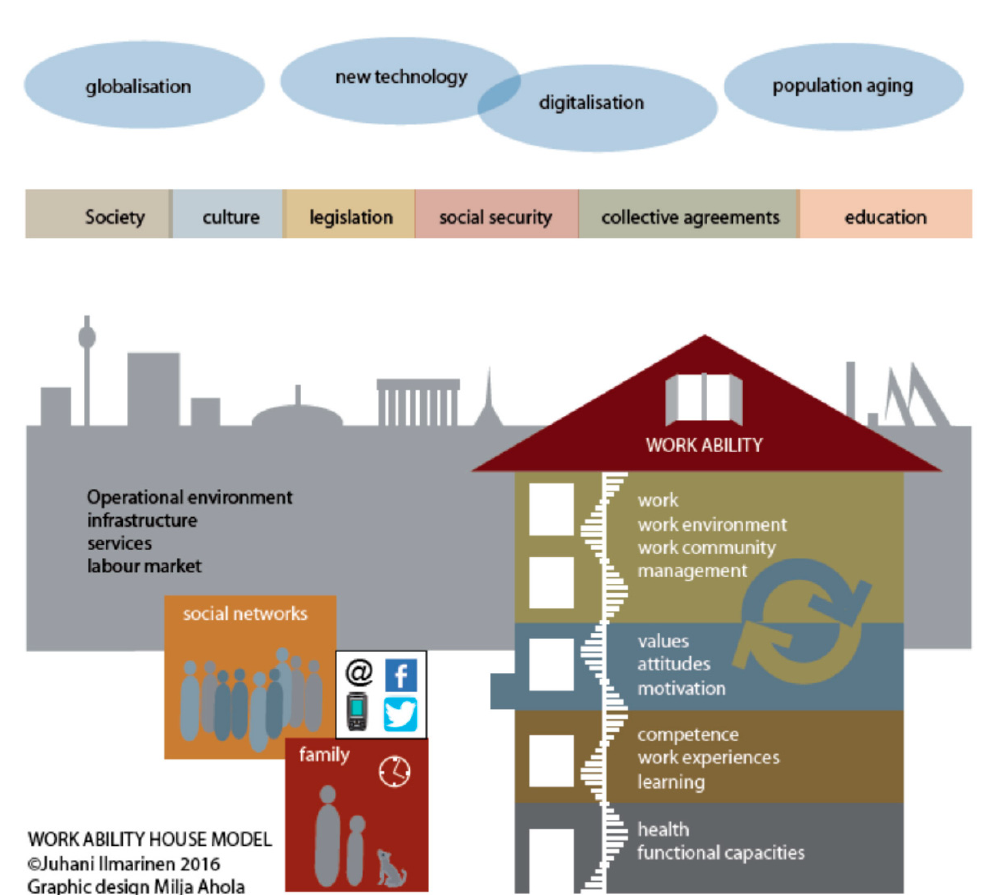
Figure 3. An illustration of the work ability house model taken from the latest published version